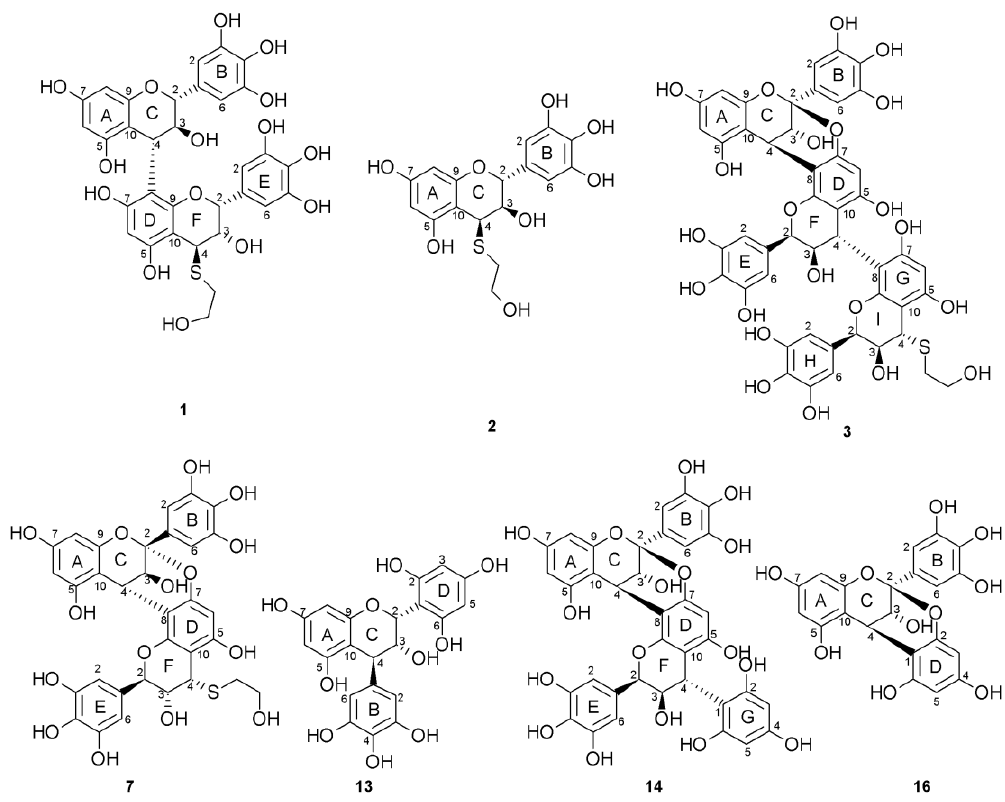
Figure 5. Structures of the new products obtained by the thiolysis and phloroglucinolysis of E. sinica proanthocyanidin oligomers.